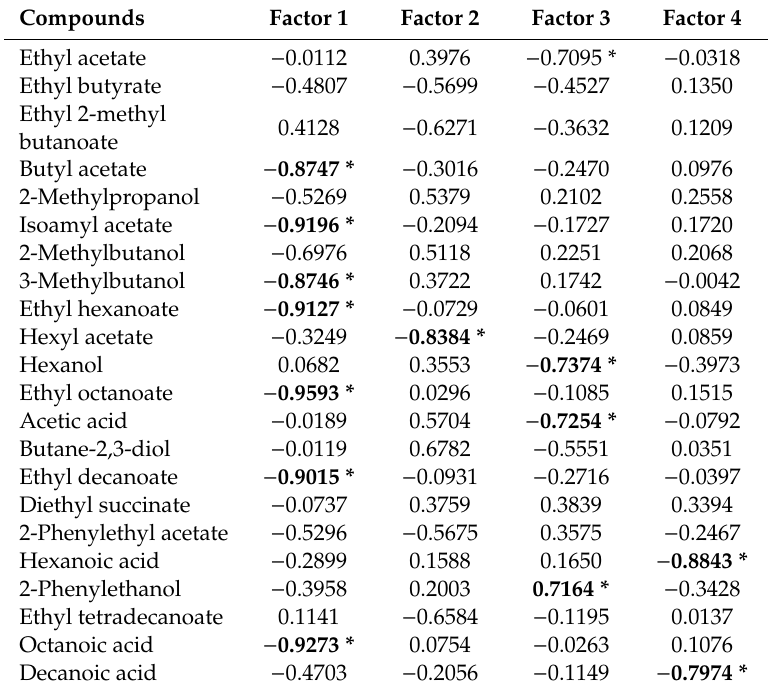
Table 3. Factor loading of the individual compounds in ciders fermented by di ff erent